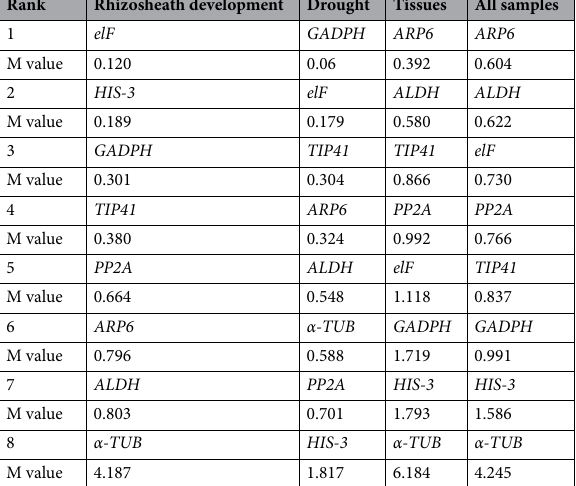
Table 2. Expression stability values (M) of the eight candidate reference genes calculated by NormFinder.